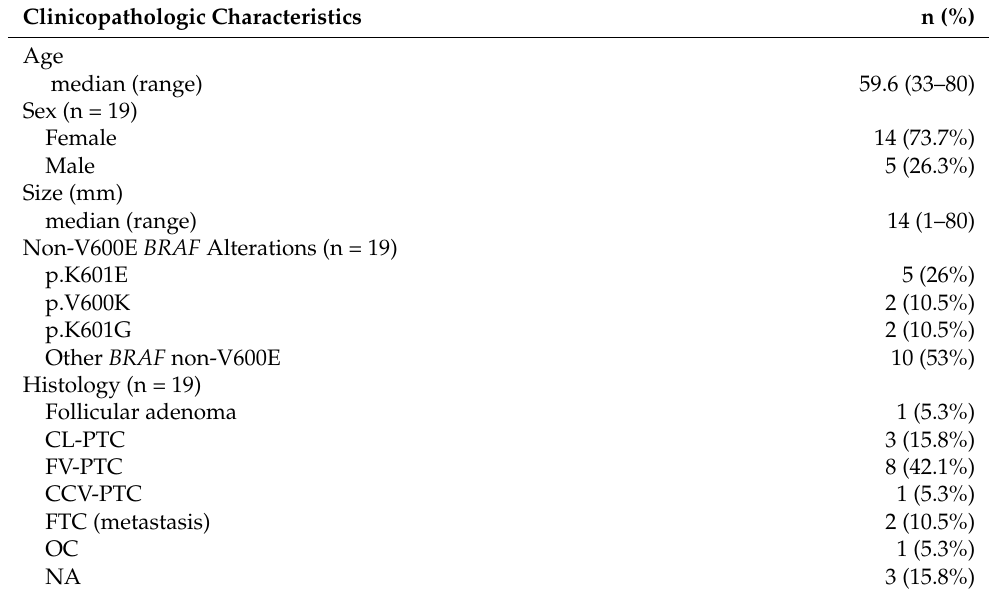
Summary of clinicopathological characteristics of the 19 cases harboring